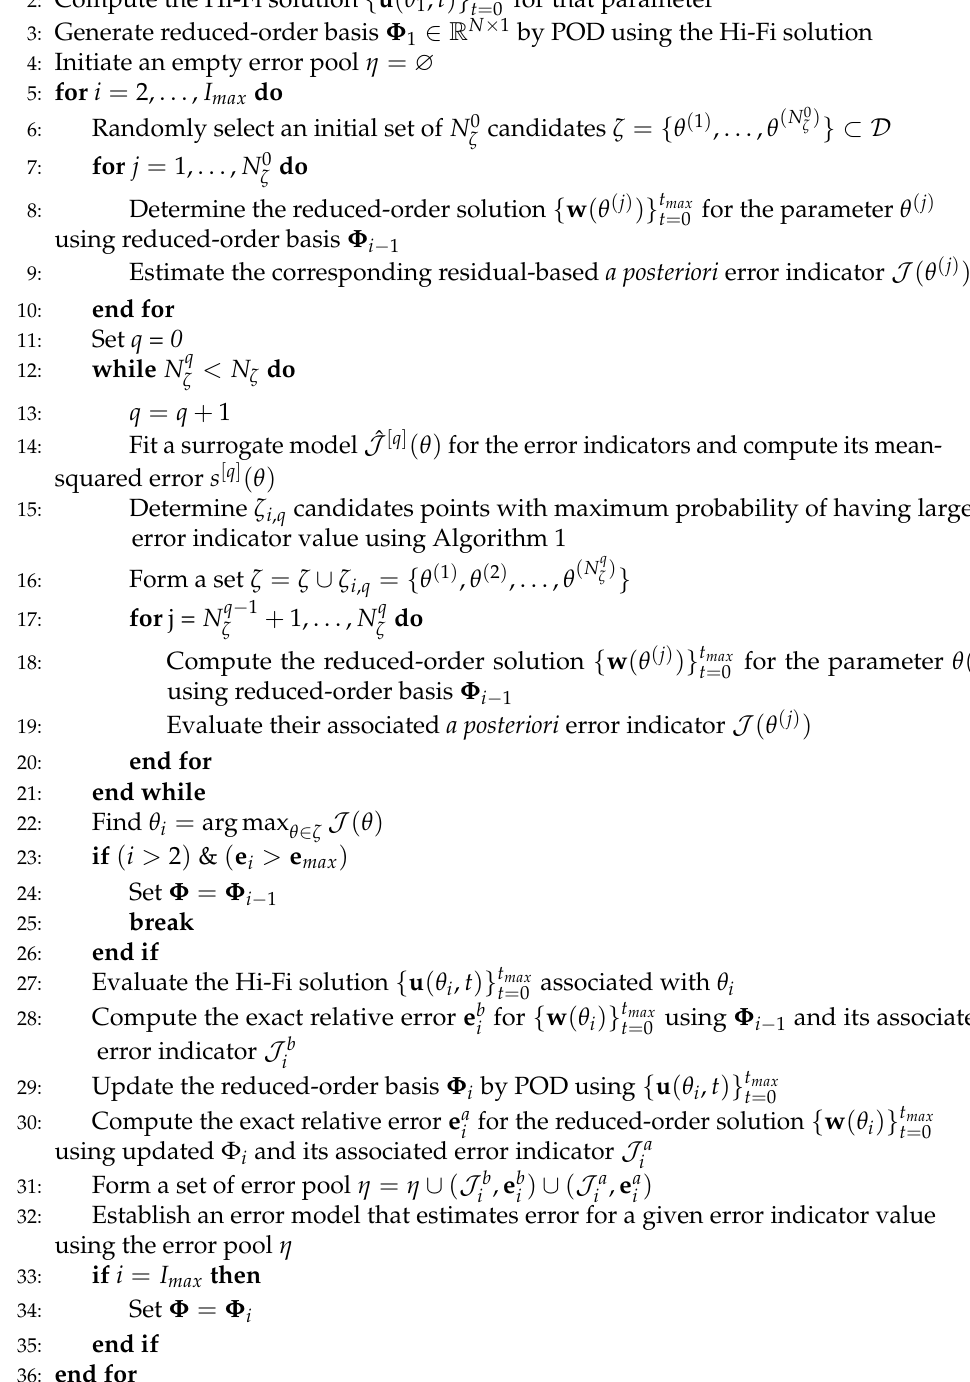
Algorithm 2 Adaptive POD-Greedy